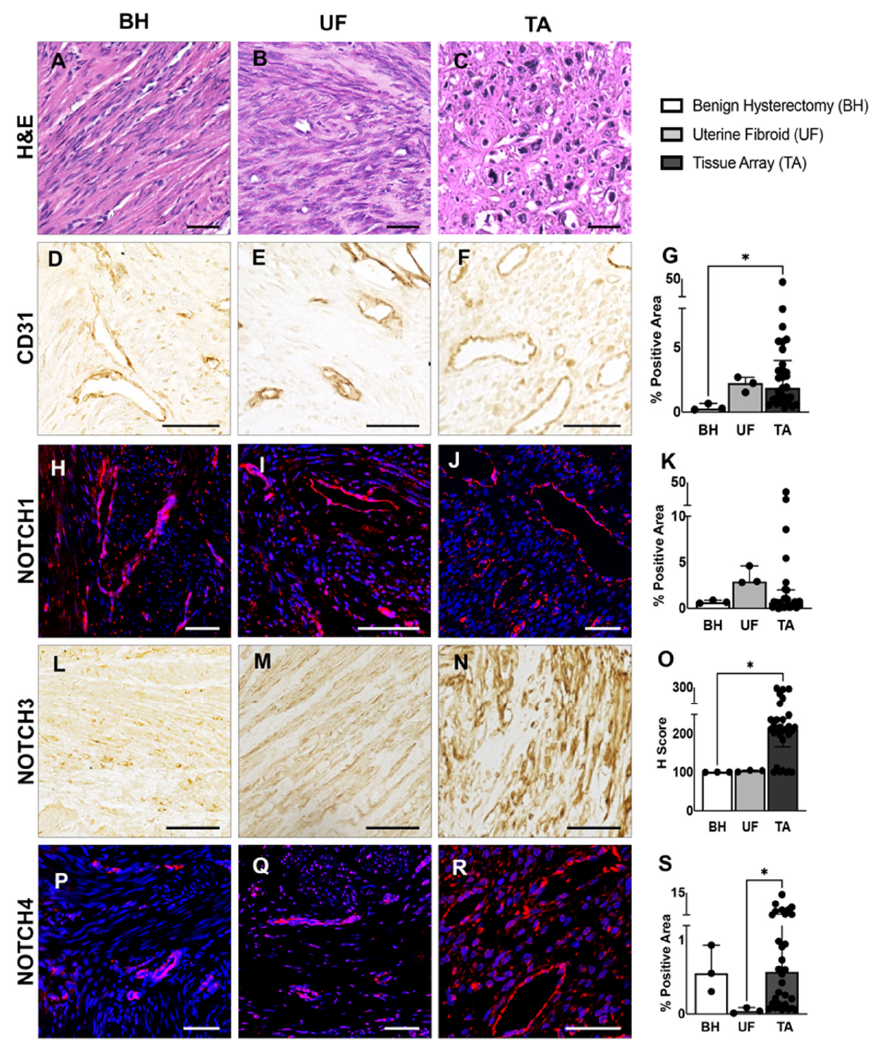
Figure 2. Notch expression in benign uterine tissues and uLMS. ( A – C ) Representative H&E images of uterine tissue from hysterectomies for benign pathology (BH, n = 3), uterine fibroids (UF, n = 3), and uLMS tissue array samples (TA, n = 30). ( D – F ) Representative images of CD31 immunostaining. ( G ) Expression of CD31 in uLMS TA samples was higher than in BH samples (* p < 0.05). ( H – J ) Representative images of immunostaining for NOTCH1. ( K ) Expression of NOTCH1 was similar in BH, UF, and TA tissue samples. ( L – N ) Representative images of immunostaining for NOTCH3. ( O ) Expression of NOTCH3 was higher in uLMS TA samples than in BH samples (* p < 0.05). ( P – R ) Representative images of immunostaining for NOTCH4. ( S ) Expression of NOTCH4 in uLMS TA samples was significantly higher than in UF samples (* p < 0.05). Data are represented as median + IQR. Scale bars = 50 µm.